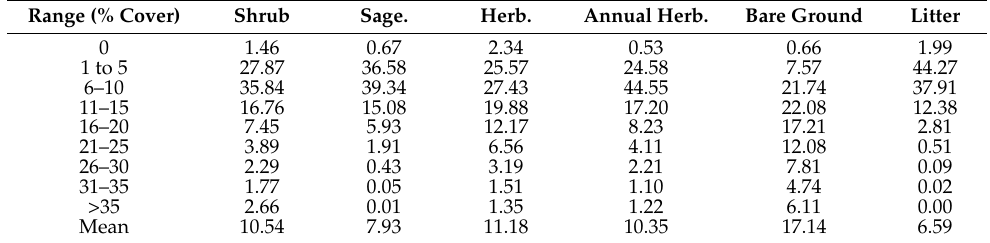
Table 2. Proportion (%) of study area by component cover range throughout the 1985–2018 time-series. Range was calculated as the minimum cover value subtracted from the maximum cover value. Range (% Cover) Shrub Sage.